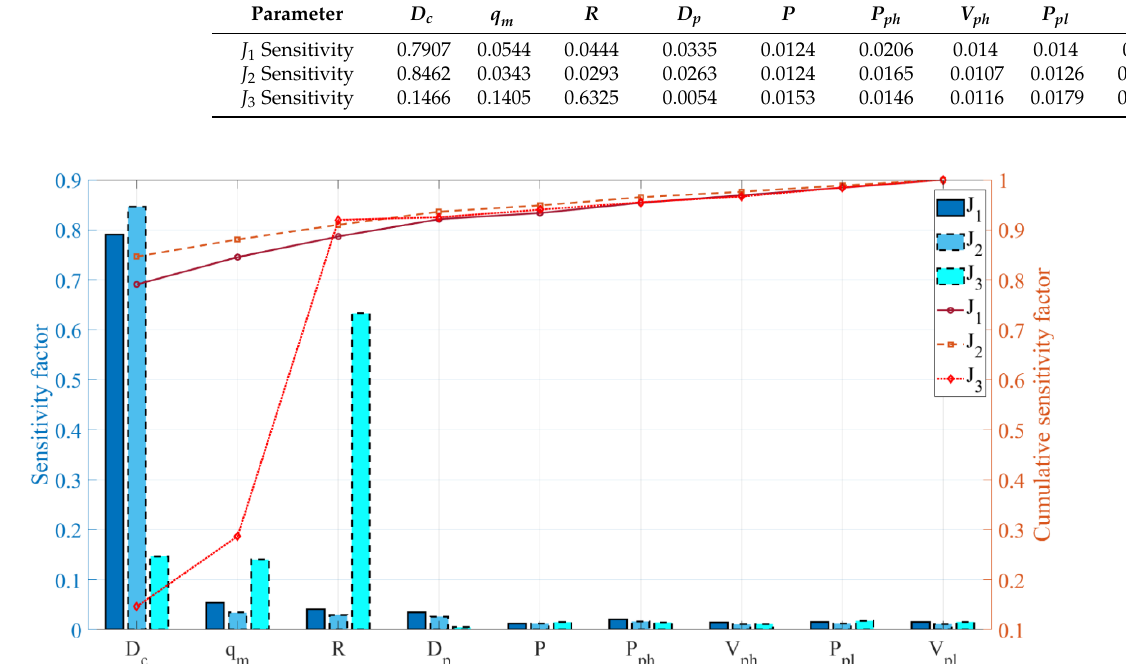
Figure 4. The sensitivity factors and the cumulative sensitivity factors of various parameters for the ride comfort 𝐽 1 , the road holding 𝐽 2 , and the energy-harvesting power 𝐽 3 . ride comfort J 1 , the road holding J 2 , and the energy-harvesting power J 3